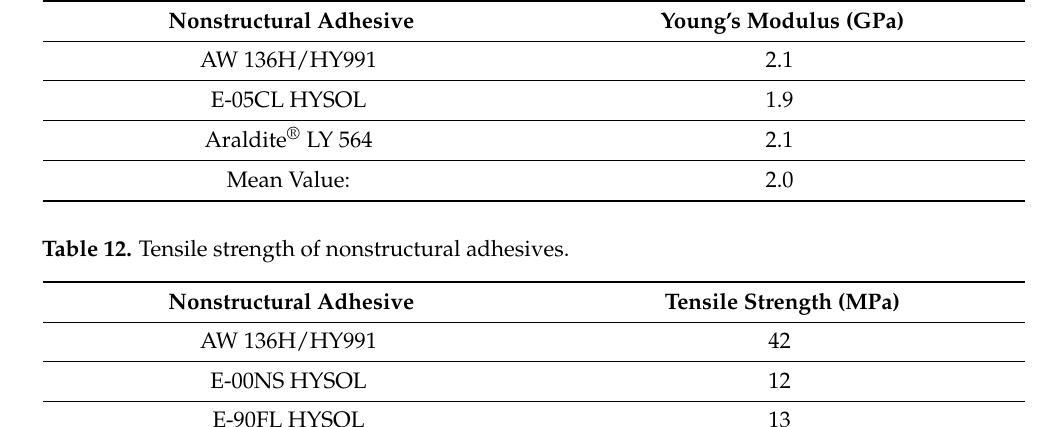
Table 11. Young’s modulus of nonstructural adhesives.